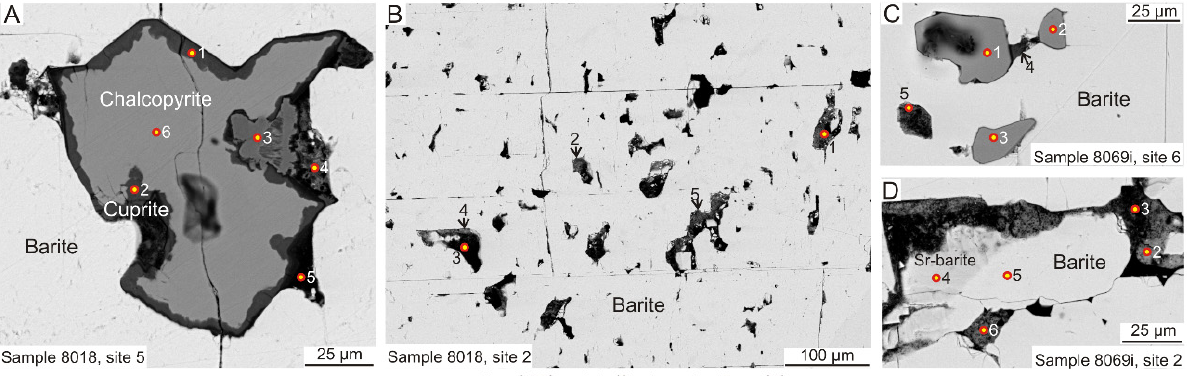
Figure 6. BSE images of mineral and fluid inclusions in barite veins. ( A ) Fractured chalcopyrite inclusion (analysis 6) with a cuprite and barite rim (1, 2) and engulfing pyrite (3). ( B ) Decrepitated fluid inclusions showing presence of trace amounts of Si, Al, Ca, Cl, Na (1, 2, 3, 4, 5) in various combinations. ( C ) Barite with anhedral chalcopyrite inclusions (1, 2, 3, 4) and decrepitated fluid inclusions (including traces of Si, Al, Fe, Na) (5). ( D ) Cluster of decrepitated fluid inclusions (2, 3, 6) following fractures, and patches of Sr-rich barite (4).